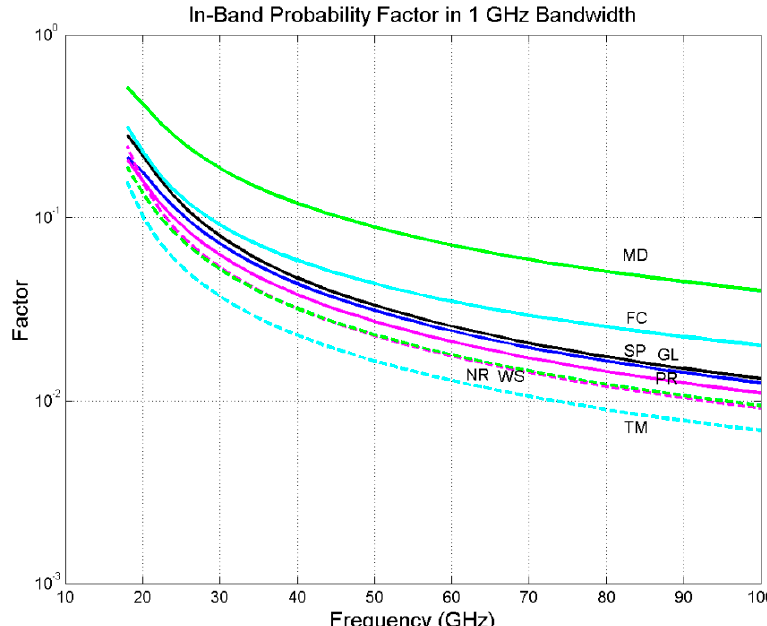
Figure 8. In-band probability factor I p , Equation (4), versus frequency, Equation (5), at the indicated sites for B w = 1 GHz: Spino d’Adda (SP, blue continuous line); Gera Lario (GL, black continuous line); Fucino (FC, cyan continuous line); Madrid (MD, green continuous line); Prague (PR, magenta continuous line); Tampa (TM, cyan dashed line); Norman (NR, magenta dashed line); White Sands (WS, green dashed line), in zenith paths.